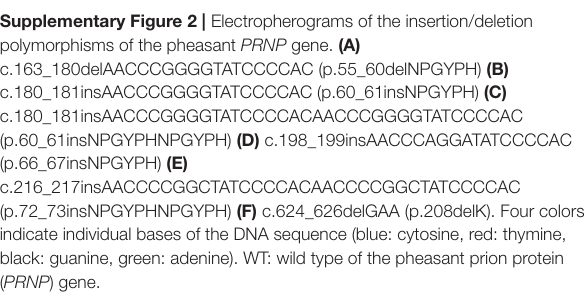
Supplementary Figure 1 | Electropherograms of 28 novel single nucleotide polymorphisms (SNPs) of the PRNP gene in pheasants. Four colors indicate the individual bases of the DNA sequence using an ABI3730xl automatic sequencer (blue: cytosine, red: thymine, black: guanine, green: adenine). The upper panels indicate major homozygotes, the middle panels indicate heterozygotes, and the lower panels indicate minor homozygotes. Supplementary Figure 2 | Electropherograms of the insertion/deletion polymorphisms of the pheasant PRNP gene.